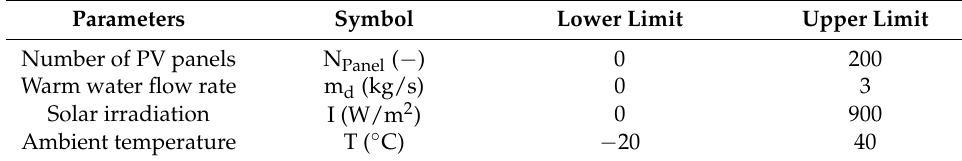
Figure 8. Energy and exergy efficiencies versus the flow rate of the hot water. Table 3 provides the decision variables that influence the objective function along with acceptable values to maximize the exergy and energy efficiencies at the same time. Table 3. Design parameters and their variation ranges for optimization.